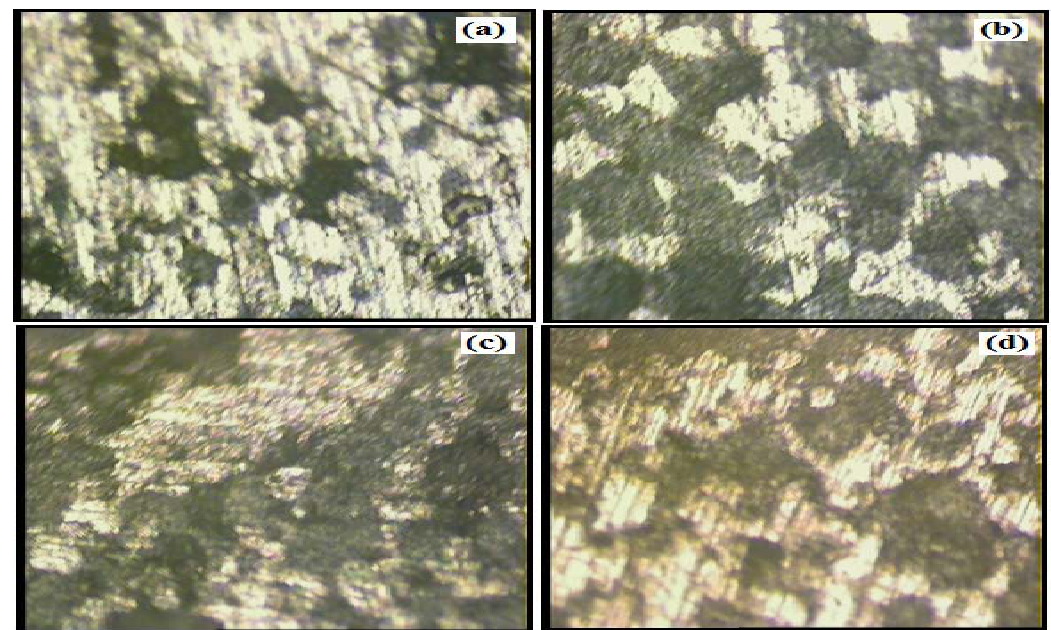
Fig. 4: Microscopic structure of coating layers after thermal treatment prepared at different distances (a) 8 cm, (b) 12 cm, (c)16 cm and (d) 20 cm.